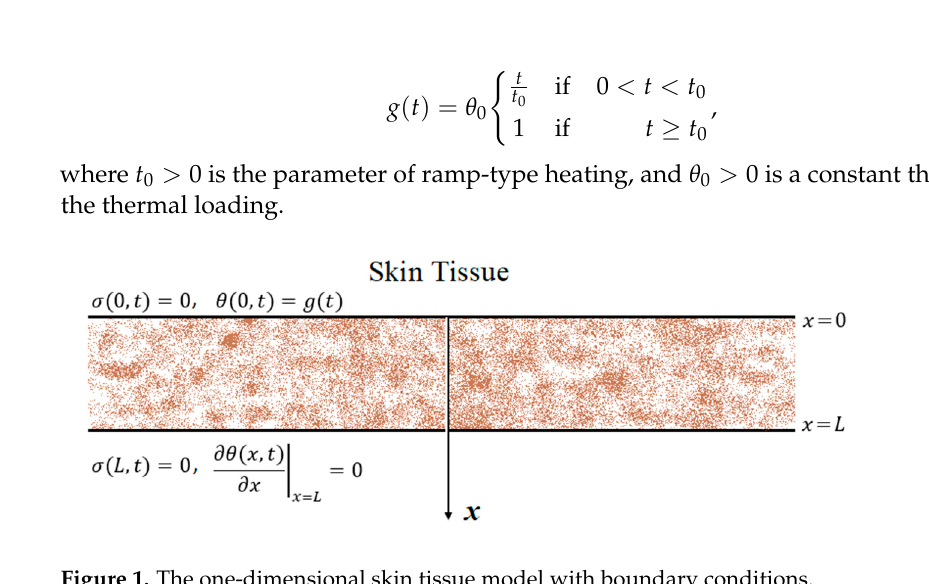
Figure 1. The one-dimensional skin tissue model with boundary conditions.